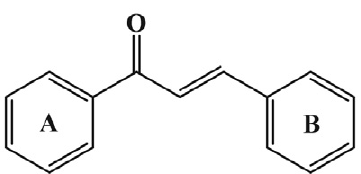
Figure 1: General structure of a